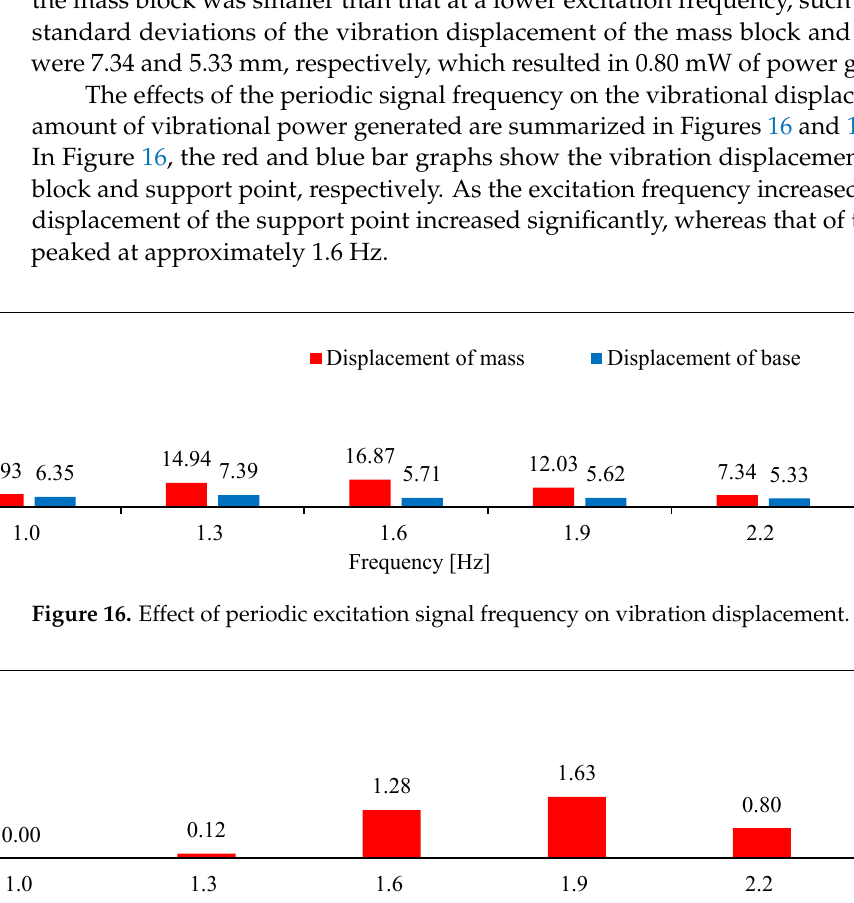
Figure 15. Measurement results for 2.2 Hz periodic signal excitation.